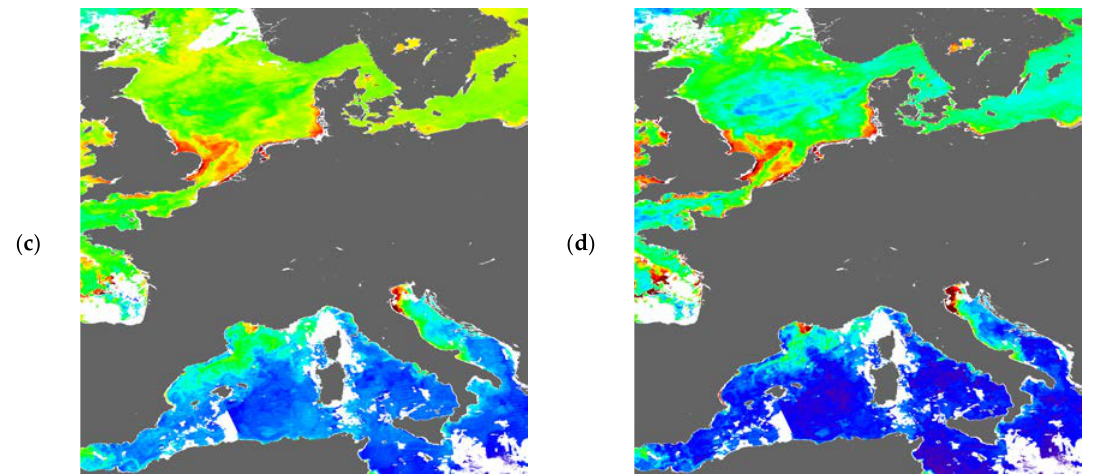
Figure 7. Weighted composites and their uncertainty. ( a ) Uncorrected weighted composite of chl in mg m − 3 from 1 to 8 May 2013 using the mean of ln(chl); ( b ) uncertainty in the uncorrected composite due to bias, standard deviation, standard error, and estimated natural variability of ln(chl); ( c ) bias corrected weighted chl composite; ( d ) uncertainty in the corrected composite due to standard deviation, standard error, and estimated natural variability of ln(chl).